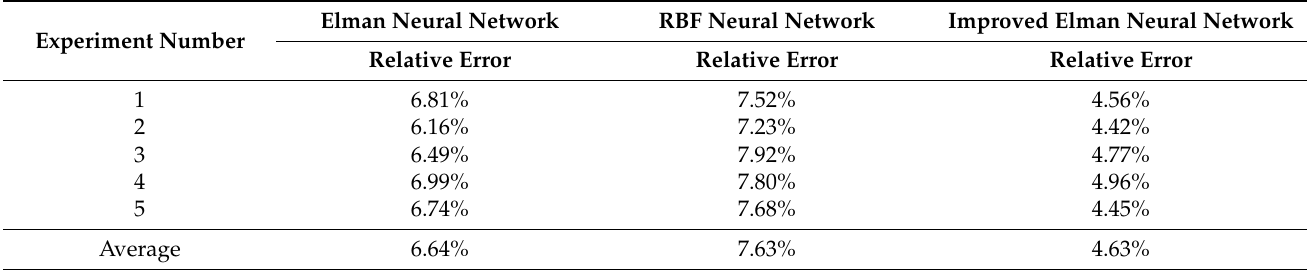
Table 5. Cross-validation experimental results of the proposed model with other